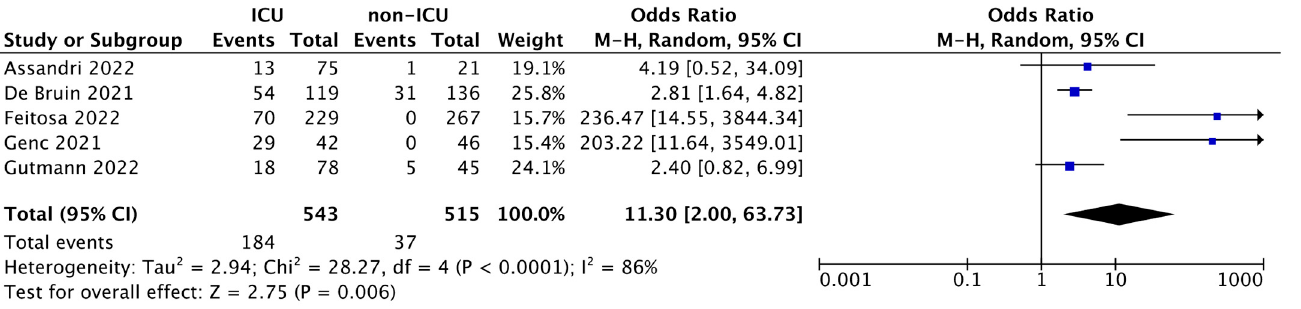
Figure 2. Forest plot of the studies included in the quantitative synthesis. The forest plot describes the mortality incidence between ICU and non-ICU patients in which PTX3 levels were assessed. The death of patients is referred as events compared to the total number of subjects. Squares display the effect estimate (ORs) with the size of each blue square corresponding to the weight given to each study in the meta-analysis. Horizontal lines represent the 95% CIs corresponding to each effect estimate. The black diamond represents the overall effect of intervention with its width representing the overall 95% CI. The I 2 statistic represents a measure of heterogeneity. Overall effect OR: 11.30 [2.00, 63.73]; p = 0.006.